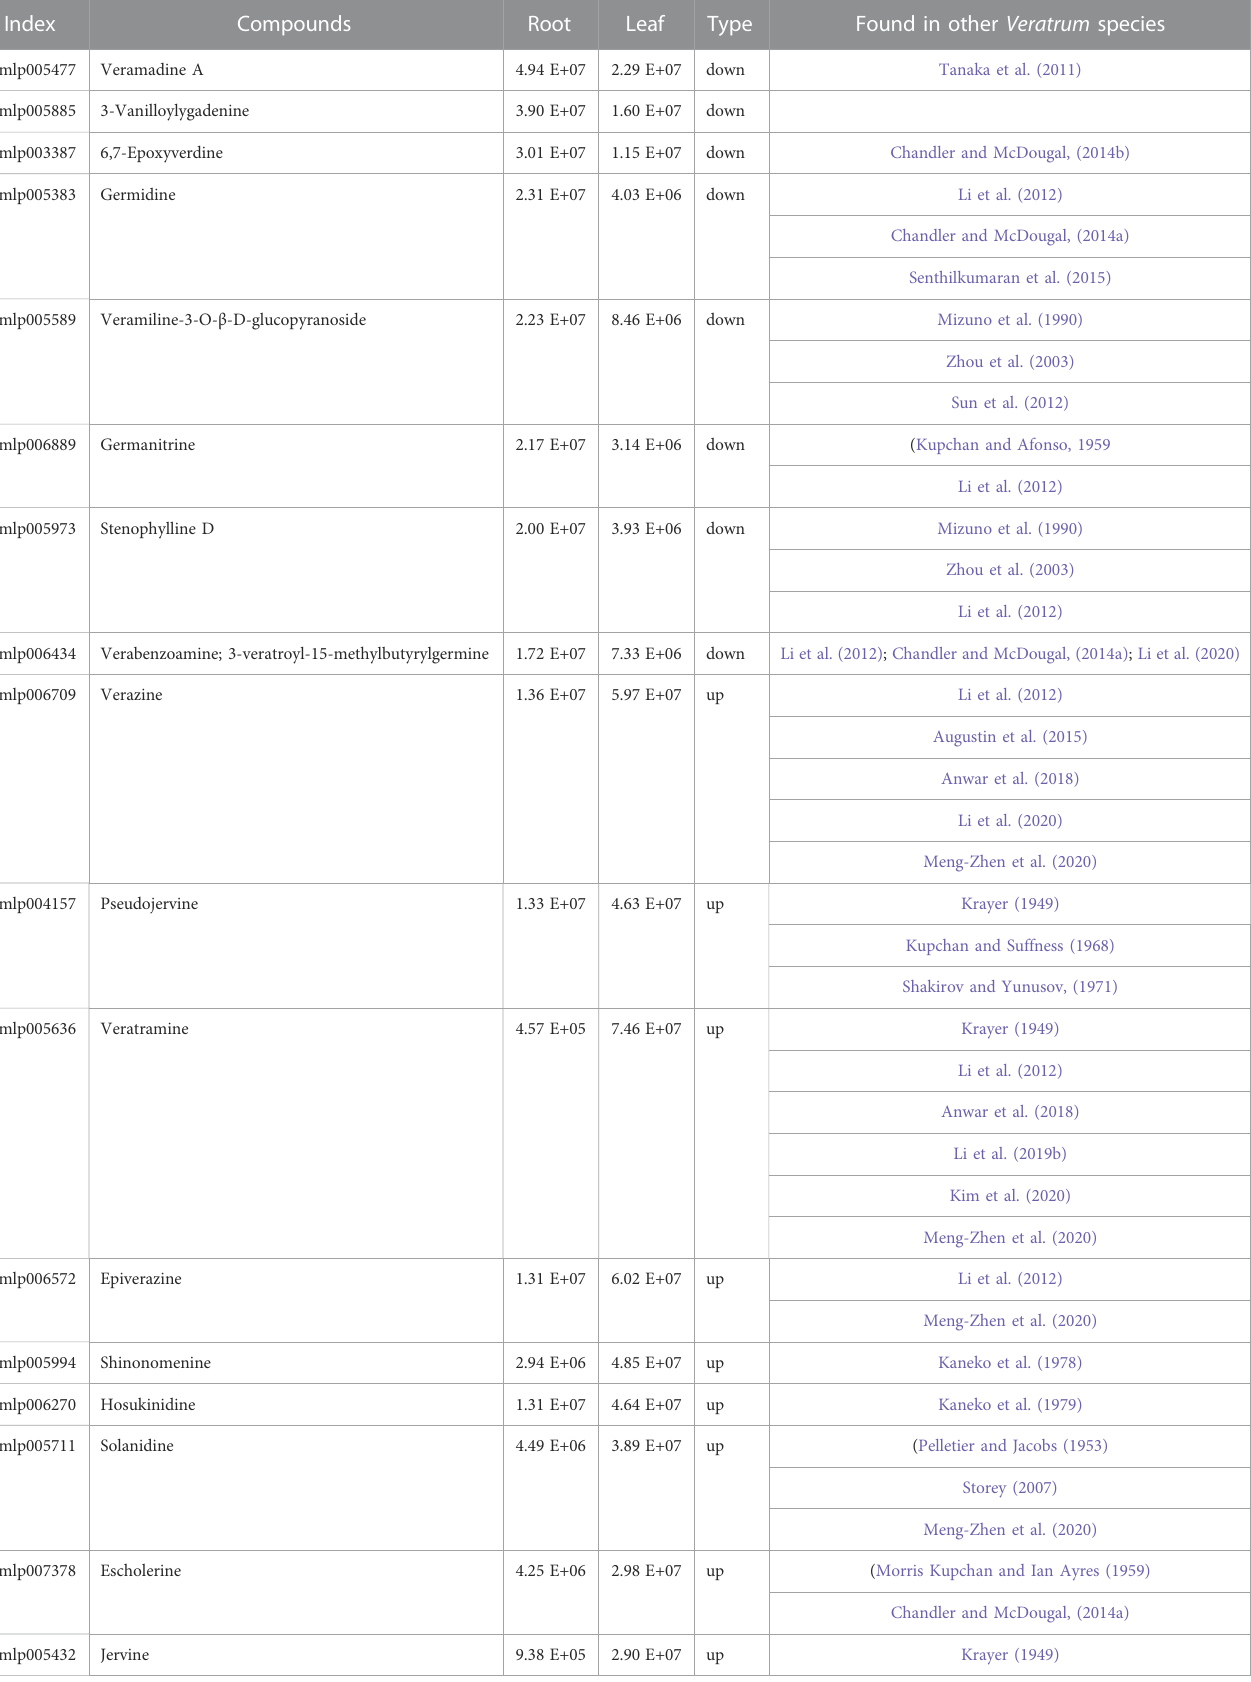
TABLE 1 List of highly accumulated steroidal alkaloids in leaf and root samples of V . mengtzeanum